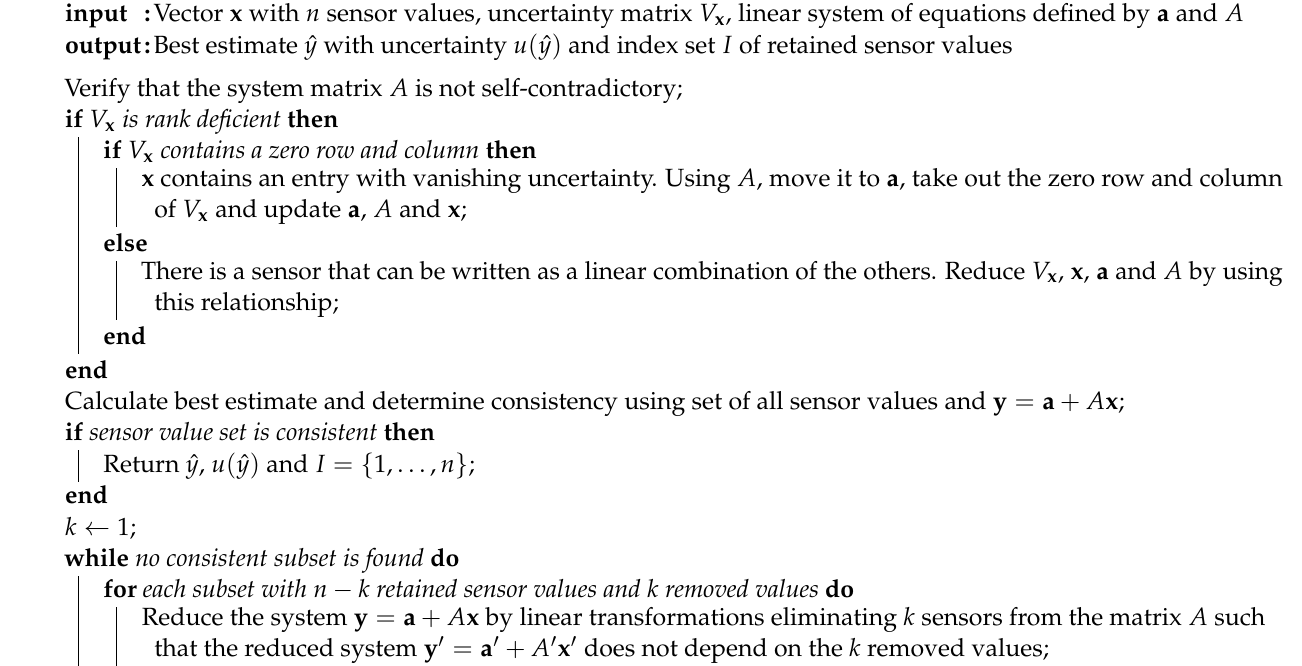
Algorithm 1: Outline of largest consistent subset of sensor values (LCSS)